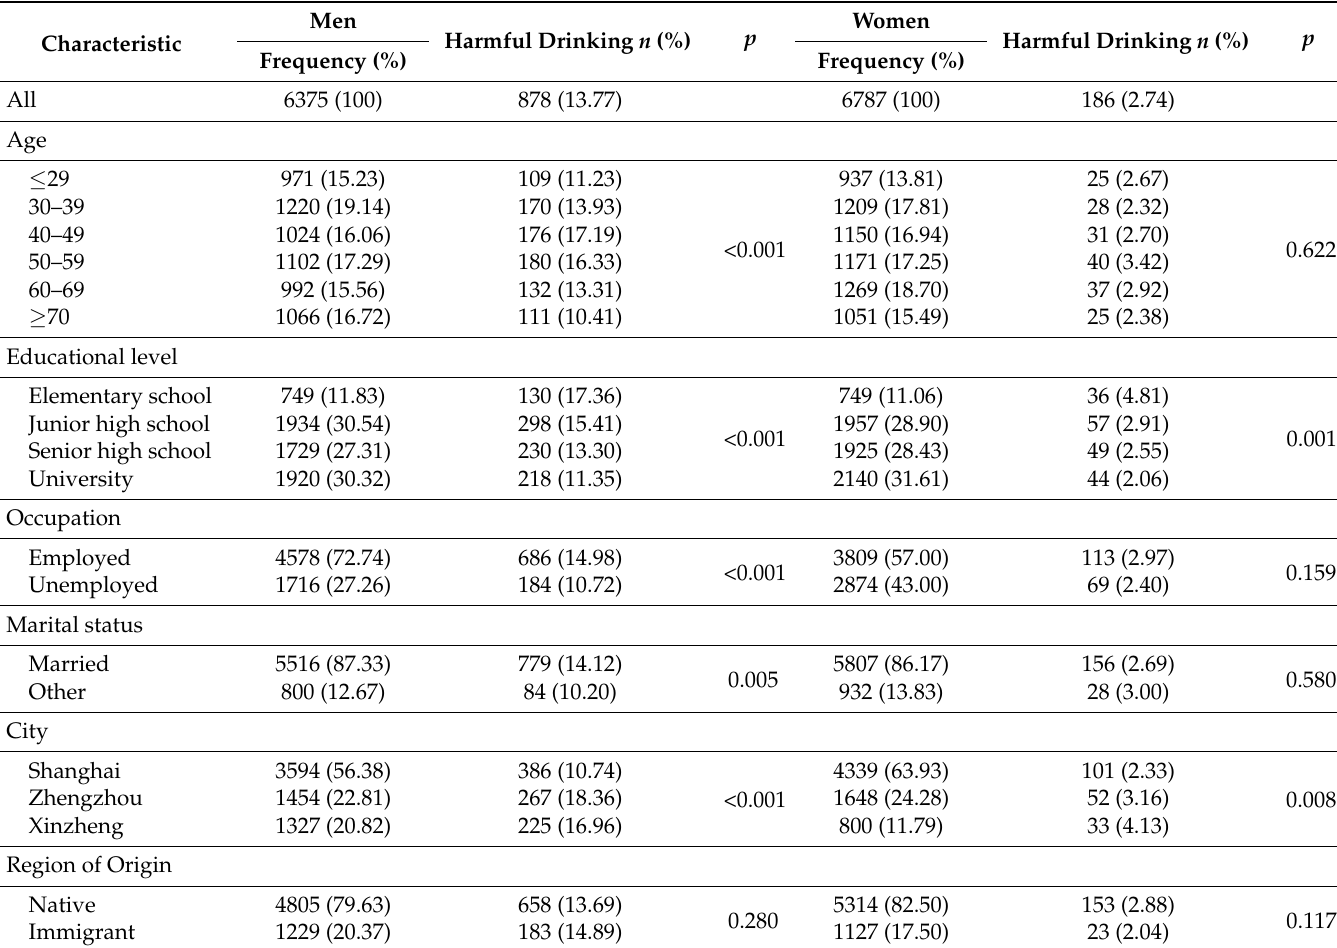
Table 1. Comparisons of the rates of HD among demographic characteristics using a univariate